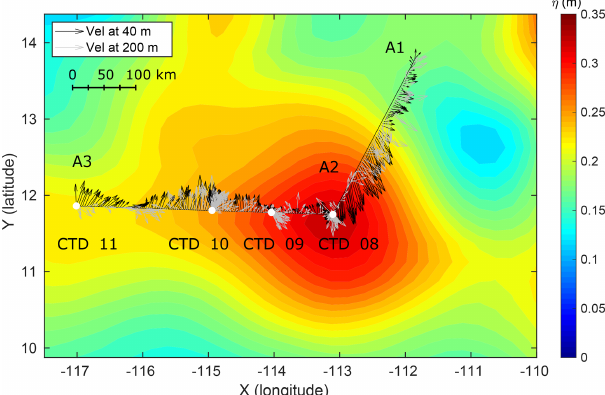
Figure 9. Current velocity at 40 and 200m water depth as the ship was crossing the northeastern eddy segment to the eddy center (tran- sect A1–A2) and then from the eddy center to the western eddy rim (transect A2–A3). The largest vector corresponds to a velocity of 45cms − 1 . White circles show the positions and times of stations at which corresponding CTD profiles were carried out. The contour plot in the background shows SLA on 2 April